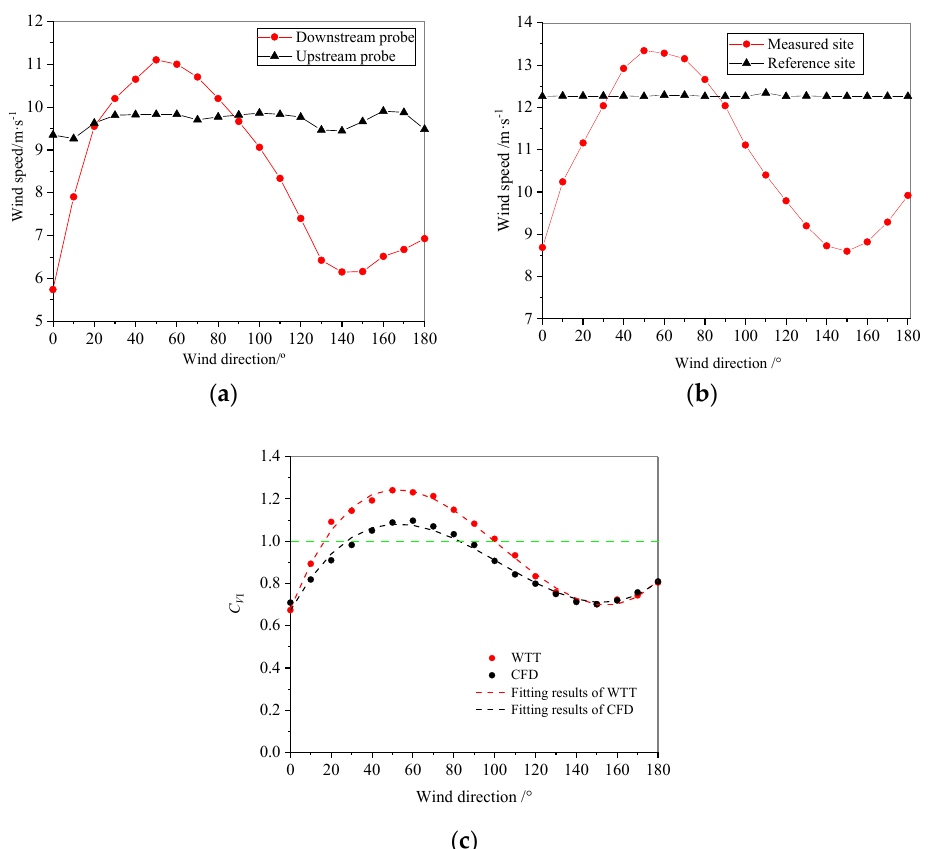
Figure 6. Description of experimental results: ( a ) relationship between wind speed and wind direction of WTT; ( b ) relationship between wind speed and wind direction of CFD; ( c ) variation of C V I with wind direction of NLDI.